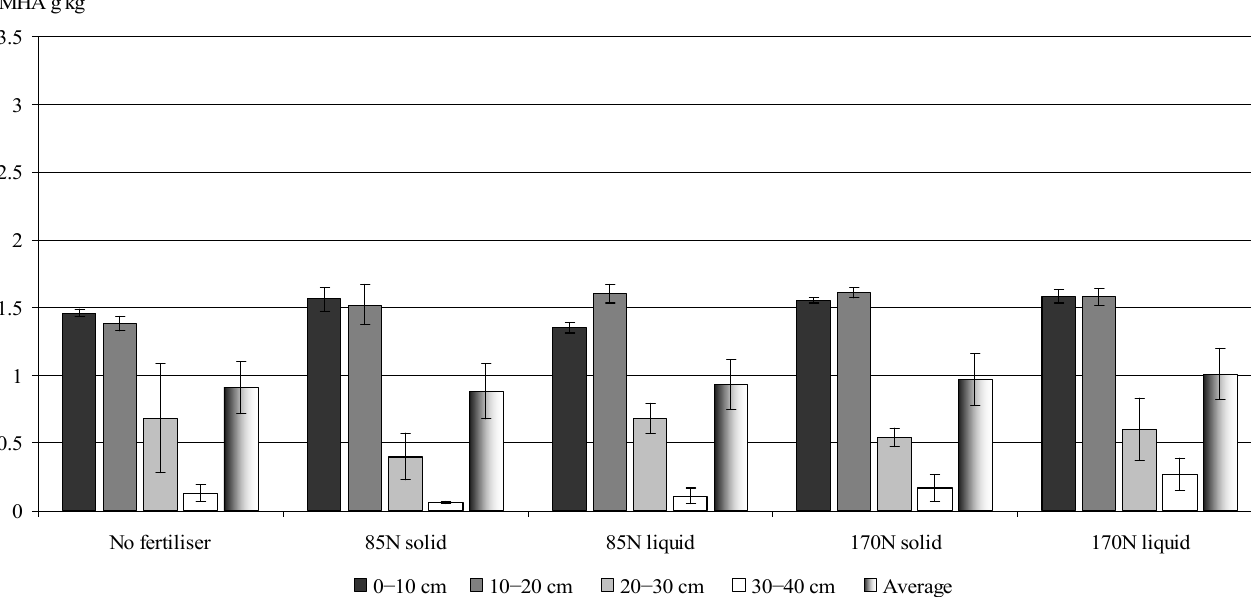
Figure 9. MHA content in the crop rotation field in Fluvisol, 2019.